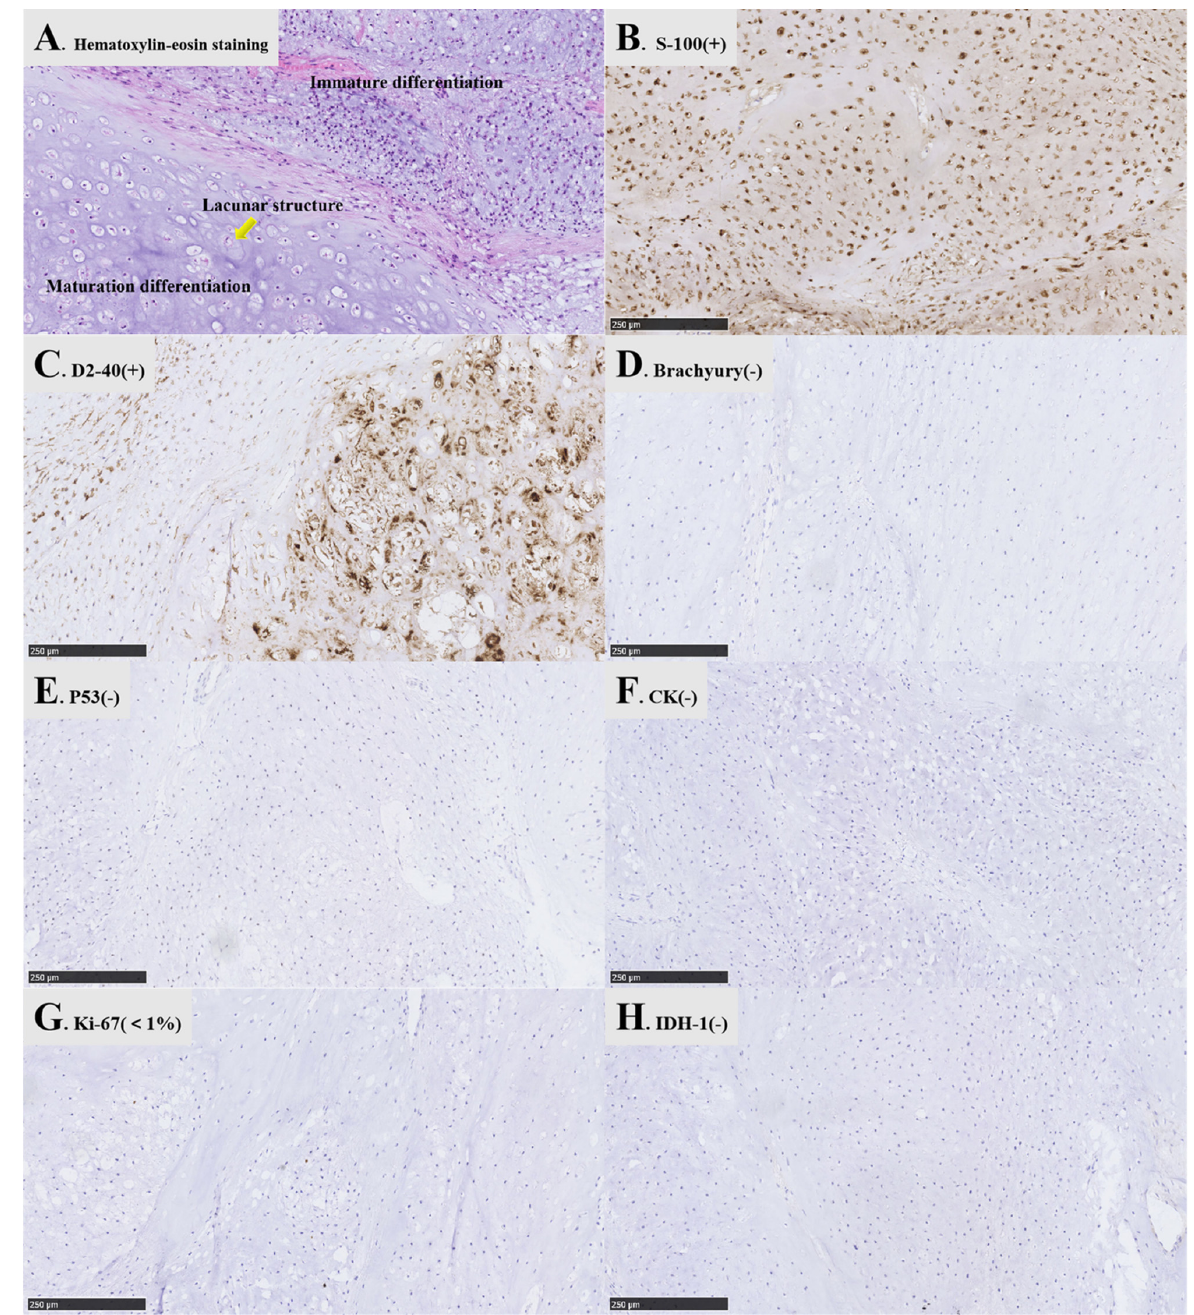
Figure 4. Pathological results at 10x magnification of parasellar chondrosarcoma. ( A ): The tumor is lobulated, partially differentiated, and mature, partially immature, and lacuna structure can be seen in the mature area; ( B ): S-100 positive, the cytoplasm and nucleus were positive in immunohistochemistry; ( C ): D2-40 positive, a specific indicator of chondrosarcoma; ( D ): Brachyury negative, an important molecular marker for differentiating chondrosarcoma and chordoma. Brachyury is positive in chondrosarcoma and negative in chordoma; ( E ): P53 negative, a tumor suppressor gene; ( F ): CK negative, it is positive in chordoma and negative in chondrosarcoma, which is an important molecular indicator to distinguish chondrosarcoma from chordoma; ( G ): Ki-67 low expression, the proliferation of representative cells is inactive; ( H ): IDH-1 negative.